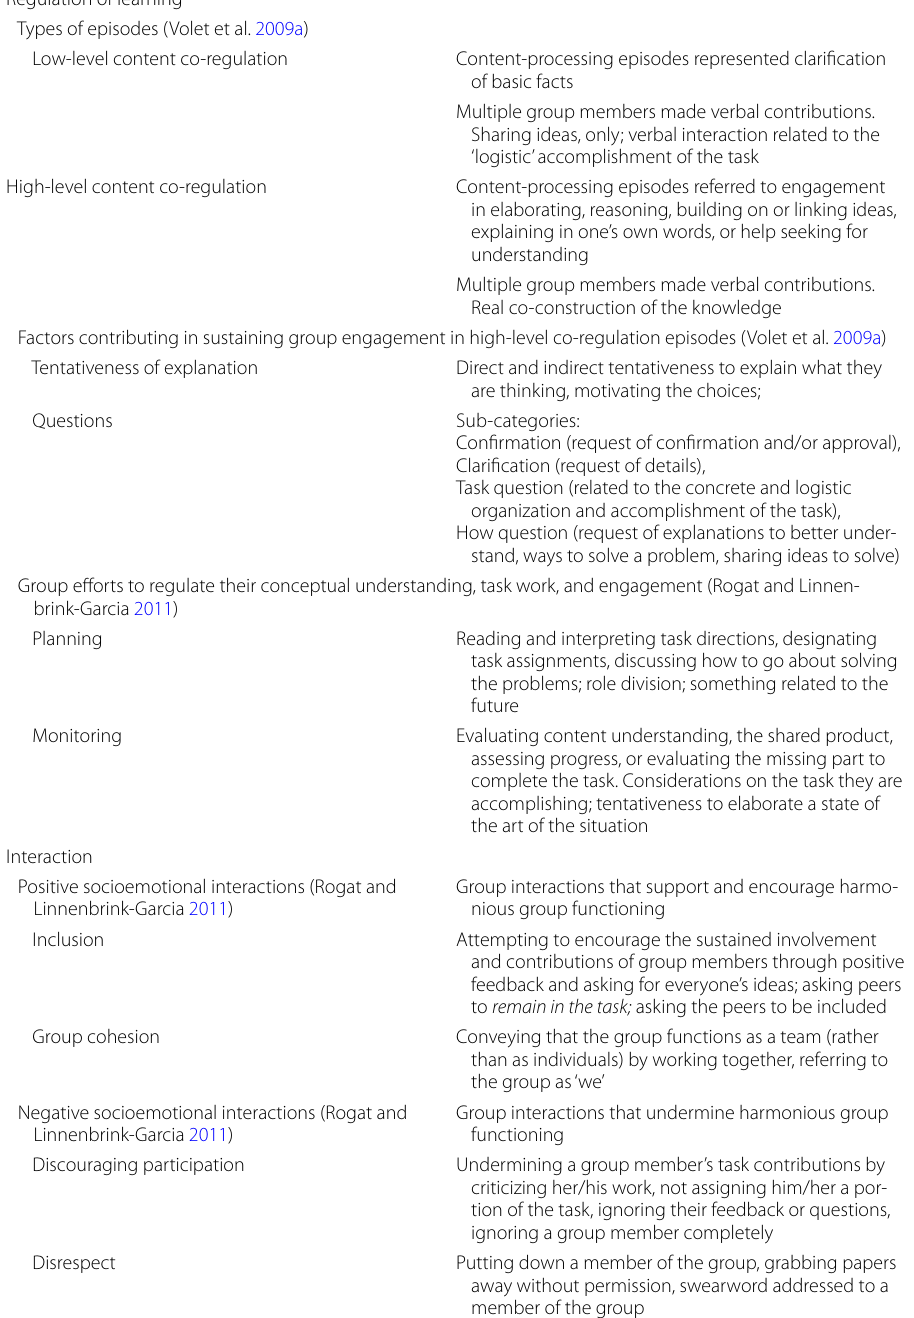
Table 1 Adapted coding scheme, inspired by Volet et al. (2009a) and Rogat and Linnen- brink-Garcia